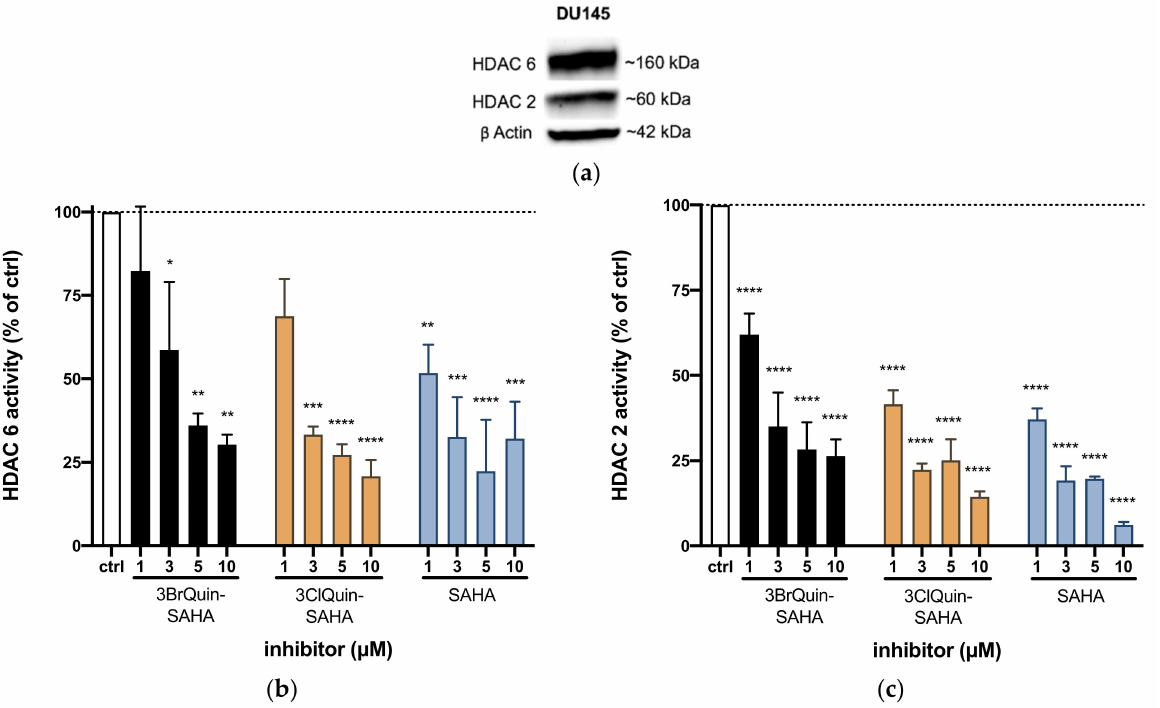
Figure 5. HDAC subtype specific inhibitory effects of 3BrQuin-SAHA and 3ClQuin-SAHA. ( a ) Western blot showing the expression levels of HDAC 2 and HDAC 6 in untreated DU145 cells (ctrl = control). ( b ) Dose-dependent inhibition of HDAC 6 and HDAC 2 ( c ) activity by 3BrQuin-SAHA, 3ClQuin-SAHA, or SAHA, respectively. Results, relative to untreated controls, as means ± SEM of n = 3 independent experiments. * p ≤ 0.05, ** p ≤ 0.005, *** p ≤ 0.0005, **** p ≤ 0.0001; two-way ANOVA Dunnett’s post hoc